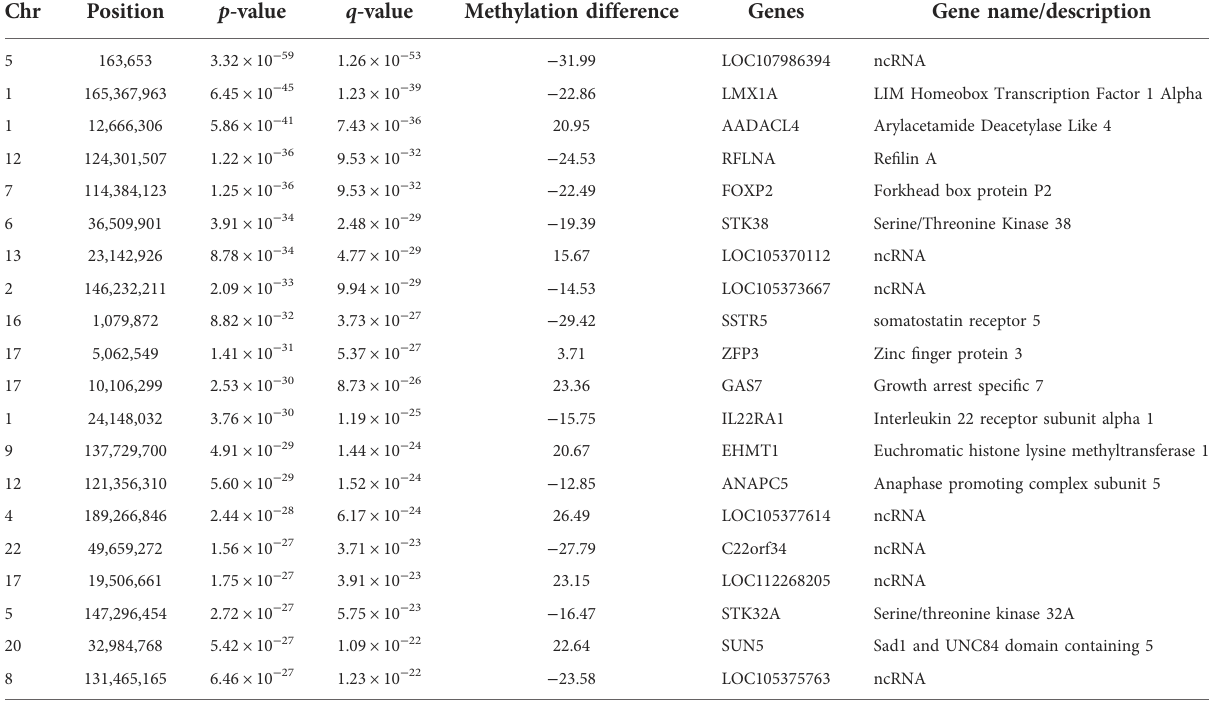
TABLE 2 Top 20 differentially methylated loci between low vs. high